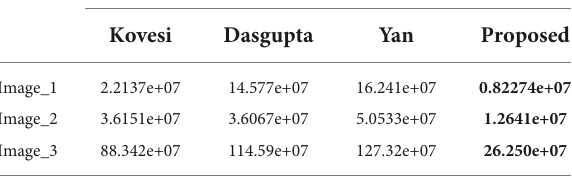
TABLE 3 The evaluation metric F of the tested images under different segmentation methods.